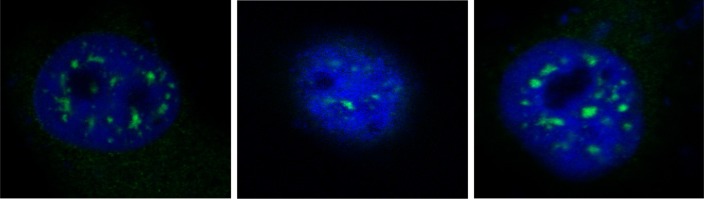
Additional Images for the proximity ligation assay showed in Figure 3D.Hela cells were transiently transfected with FLAG-tagged IRAK2 and HA-tagged SRSF1. Mouse anti-HA and Rabbit anti-FLAG antibody were used for the proximity ligation assay. Green dots present the interaction of IRAK2 with SRSF1.